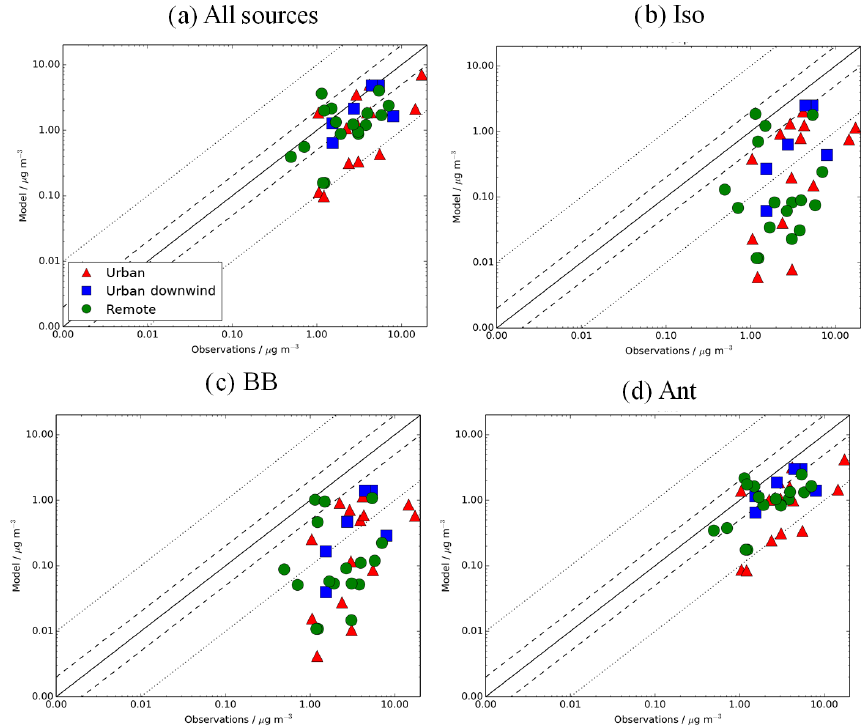
Figure 11. Simulated vs. observed SOA (µgm − 3 ) for the following simulations: (a) AllSources, (b) Iso, (c) BB, and (d) Ant, described in Table 2. Observations for the time period 2000–2010 are classified as urban (red triangles), urban downwind (blue squares), or remote (green circles). Observed OOA is assumed to be comparable to simulated SOA. The 1 : 1 (solid), 1 : 2 and 2 : 1 (dashed), and 1 : 10 and 10 : 1 (dotted) lines are indicated. Model–observation statistics for SOA are shown in Table 4.